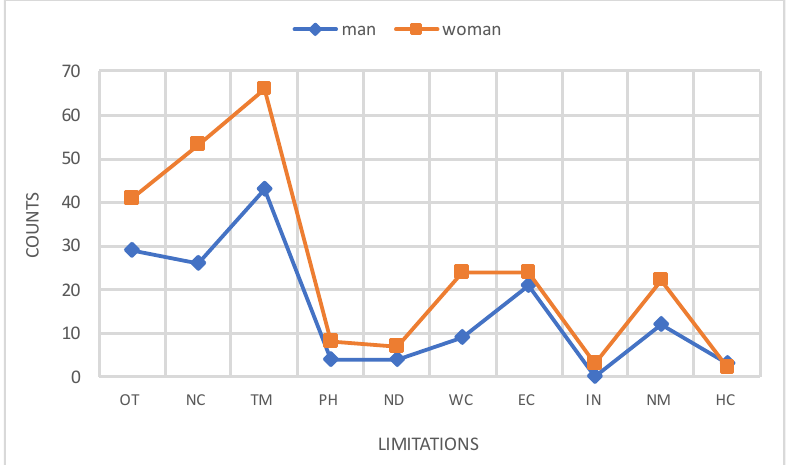
Figure 34. A graph of the interaction between limitations in the availability of tram transport and gender.